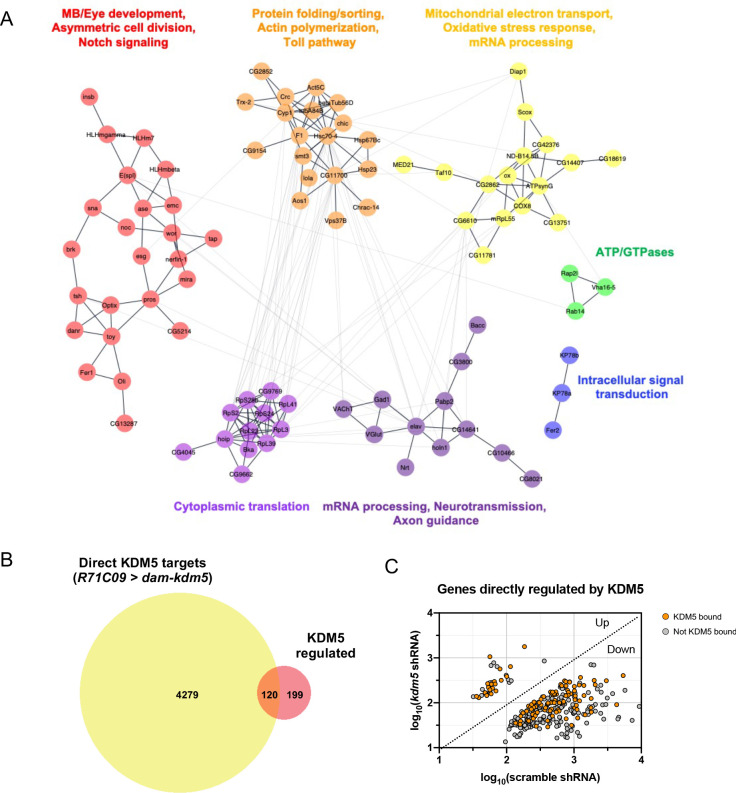
Network of known and predicted interactions between lysine demethylase 5 (KDM5)-regulated aenes and analysis of direct KDM5 targets.(A) Gene network analysis and community clustering were performed using Cytoscape with a minimum confidence score of 0.4. Networks with greater than two nodes are shown and color-coded based on cluster. Labels indicate general categories of overlapping kdm5140 and kdm5 shRNA targeted DamID (TaDa) differentially expressed genes (DEGs) within each cluster. (B) Venn diagram illustrating intersection of similarly dysregulated kdm5140 and kdm5 shRNA overlapping DEGs with direct KDM5 targets from R71C09 > dam-kdm5 TaDa. (C) Analysis of the 319 similarly dysregulated kdm5140 and kdm5 shRNA overlapping DEGs (with values plotted from the kdm5 shRNA TaDa). Direct KDM5 targets are labeled in orange. Venn diagram created with BioVenn (Hulsen et al., 2008).